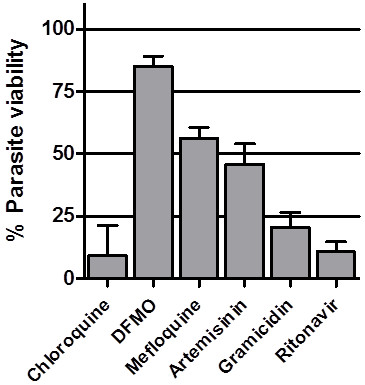
Parasite recovery from a 6-hour drug exposure. Plasmodium falciparum 3D7 parasite cultures were incubated for 6 hours with 100 nM chloroquine, 10 mM DFMO, 100 nM mefloquine, 100 nM artemisinin, 100 μM ritonavir or 0.1 nM gramicidin. The infected erythrocytes were washed and returned to culture in drug-free medium for an additional 48 hours, after which pLDH activity was determined for each culture (solid bars). Percentage parasite viability was calculated from pLDH activity relative to solvent-treated controls after subtraction of background values obtained with uninfected control erythrocyte cultures. Each drug treatment was performed in three parallel cultures and the bars represent the mean percentage parasite viability values and the error bars standard deviation.